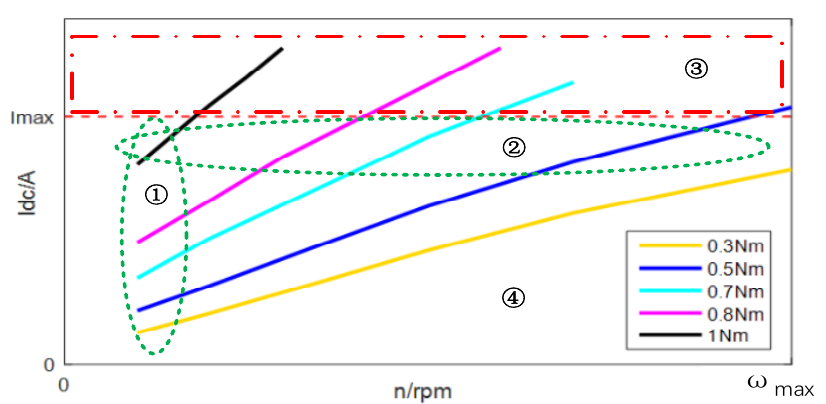
Figure 5. The variation of I dc and working sections.